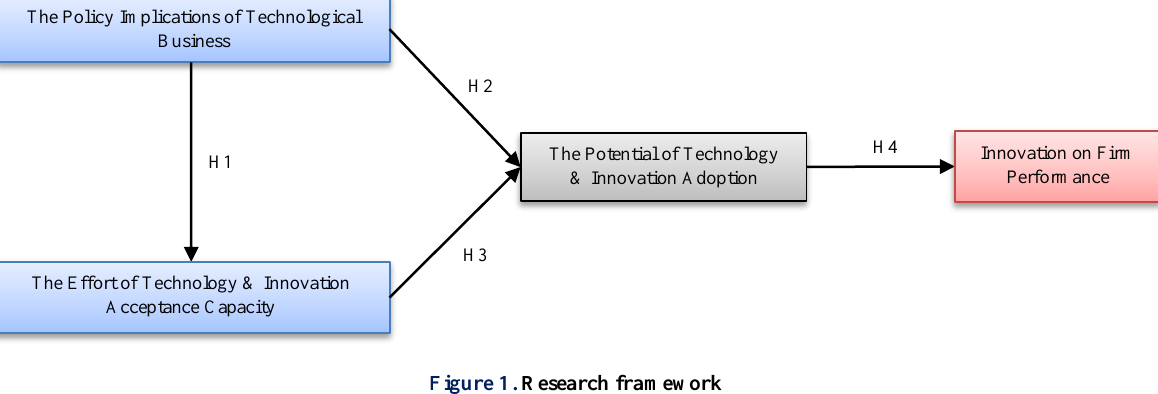
Figure 1. Research